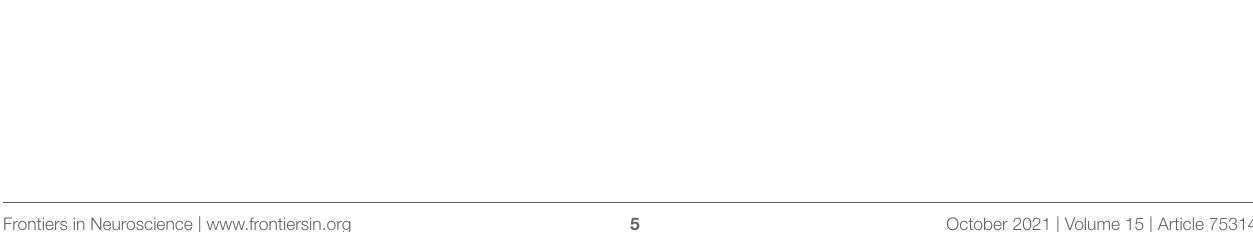
Frontiers in Neuroscience | www.frontiersin.org